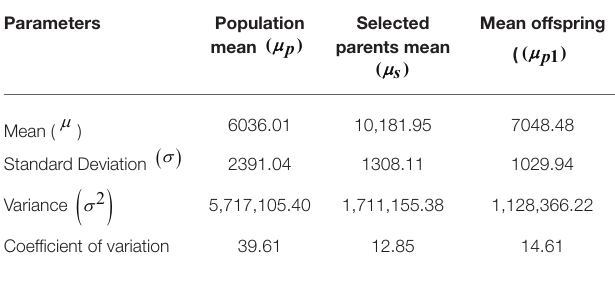
TABLE 2 | Parameters of the